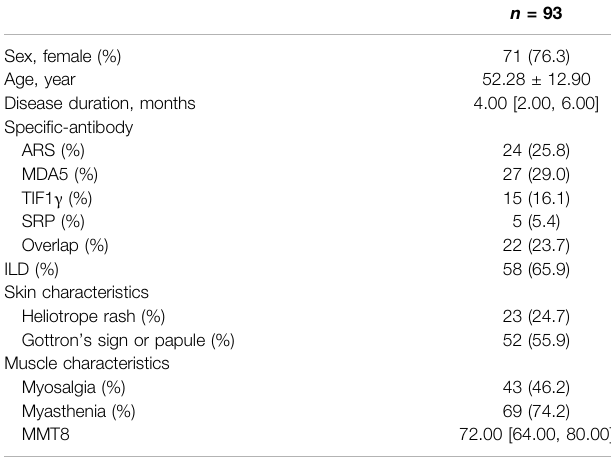
TABLE 1 | Clinical characteristics of untreated IIMs